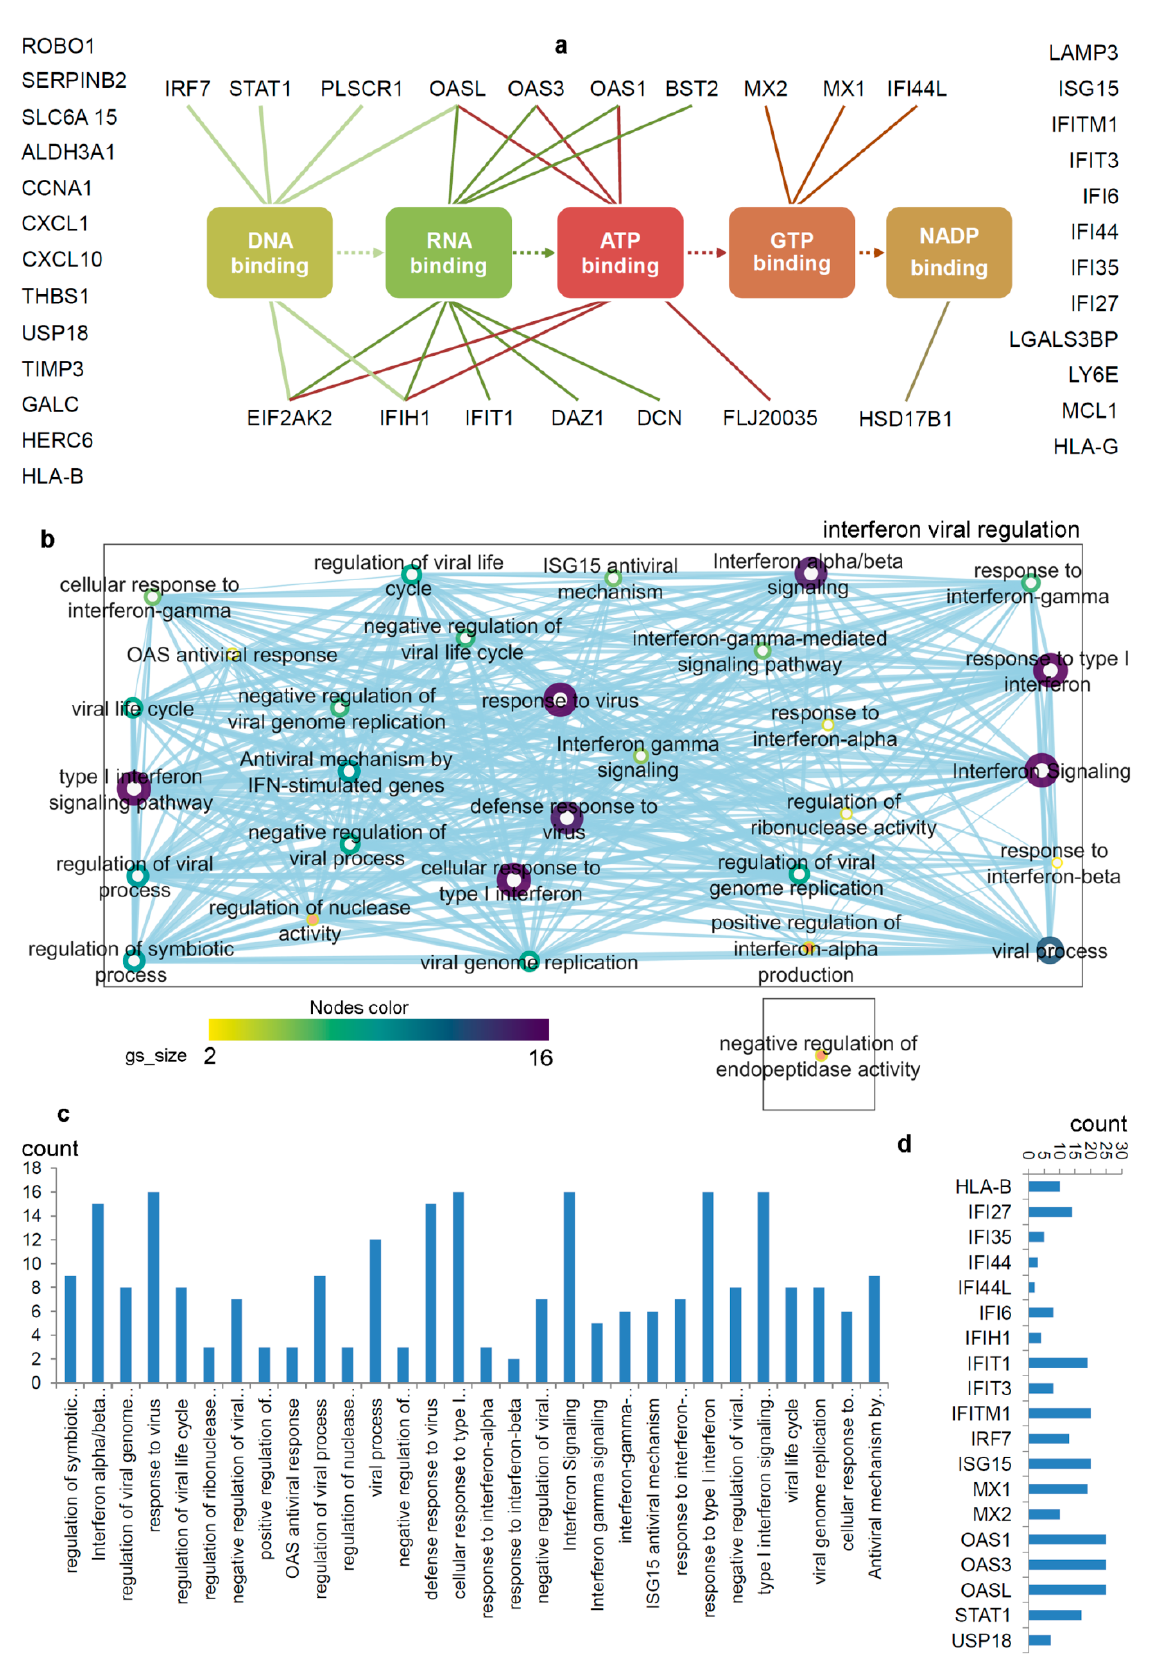
Figure 2. Differentiating IRDS genes considering their binding molecules, and associated significant biological pathways [71,74,75]. ( a ) A network describing IRDS genes involvement in binding with diverse biomolecules; DNA, RNA, ATP, GTP or NADP [77]. ( b ) Pathway enrichment analysis for the IRDS genes listed in the panel ( a ). The enrichment analysis